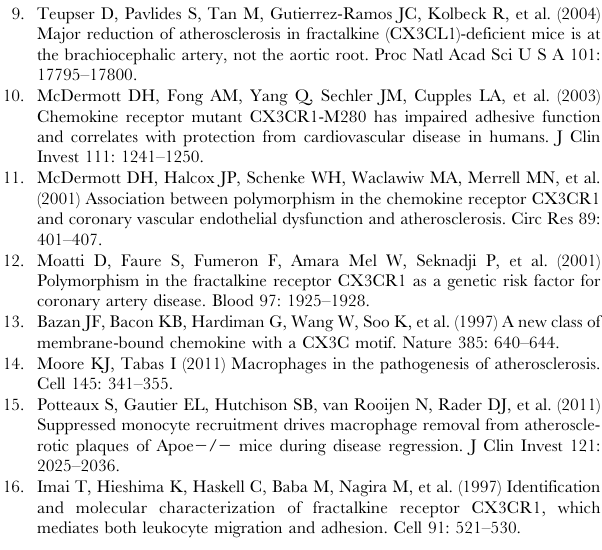
Figure S1 Control staining of atherosclerotic plaque. (TIF) Figure S2 Flow cytometry of transfected WEHI 274.1 cells. (TIF) Figure S3 FKN positive structures in an advanced atherosclerotic lesion. (TIF) Figure S4 Microvessels in atherosclerotic plaque. (TIF) Figure S5 Distribution of FKN and CX3CR1 in the atherosclerotic vascular